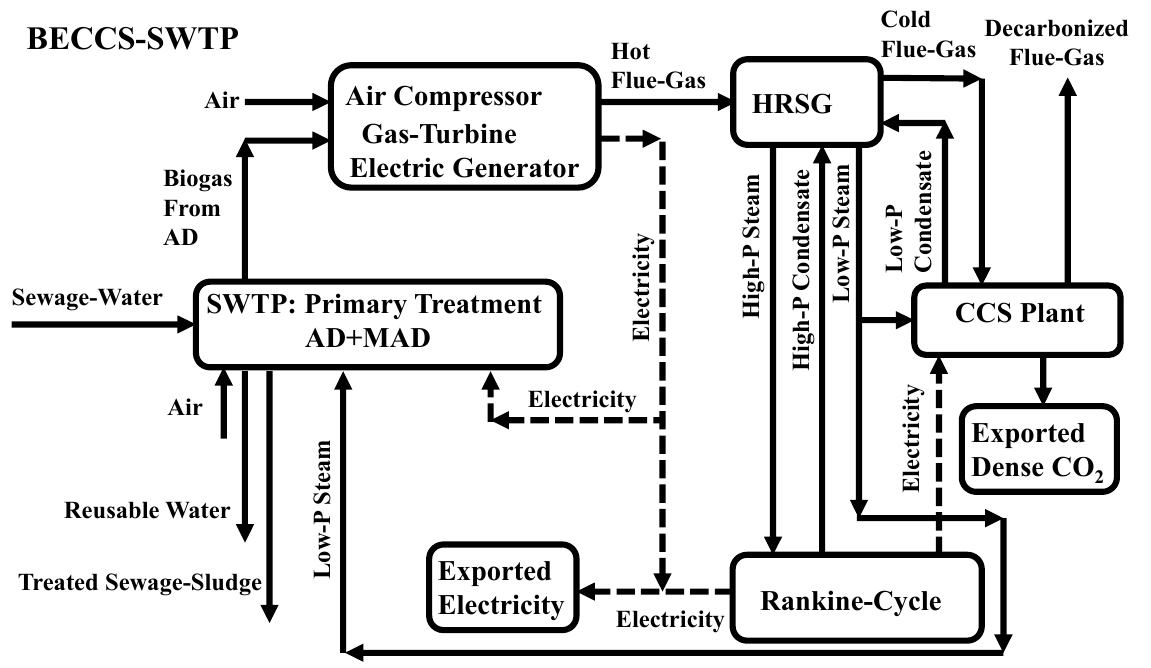
Figure 3. Conceptual BECCS SWTP from Poblete et al. (2022) [100] (Lines: Solid = material streams, Dashed = electricity).4.2. .Internal Combustion Engines